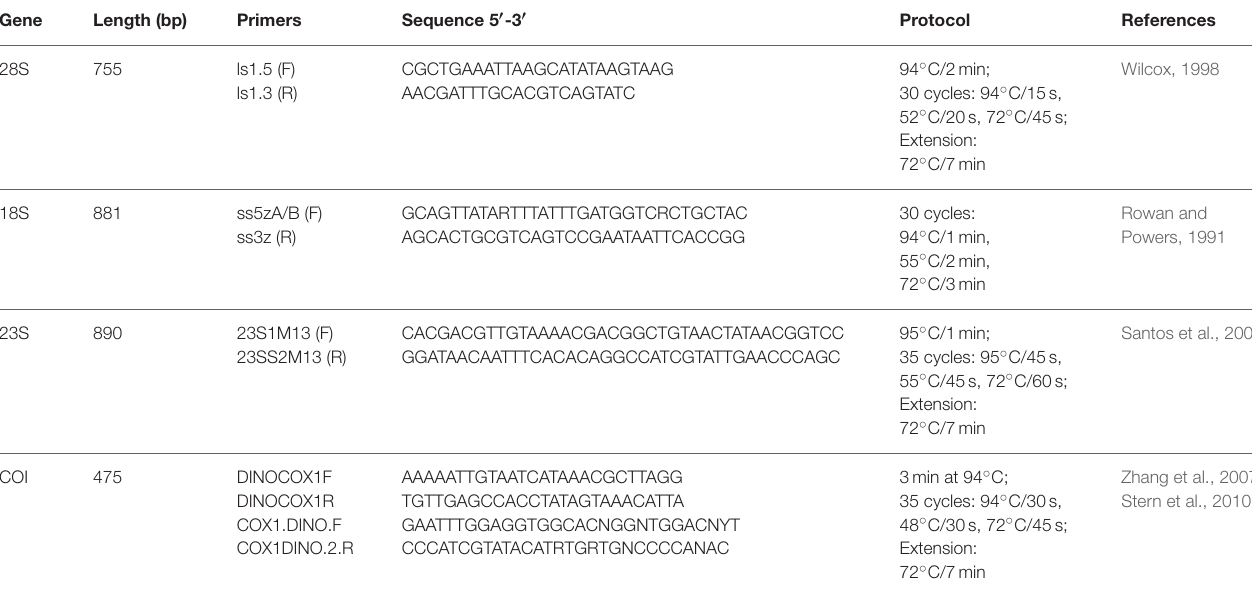
TABLE 2 | Symbiodinium specific primers and PCR protocols used in this